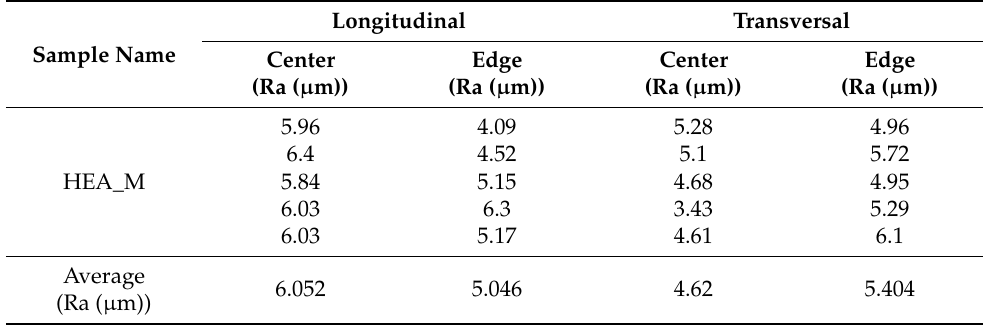
Table 1. Roughness measurement results for the CoCrFeNiMo 0.85